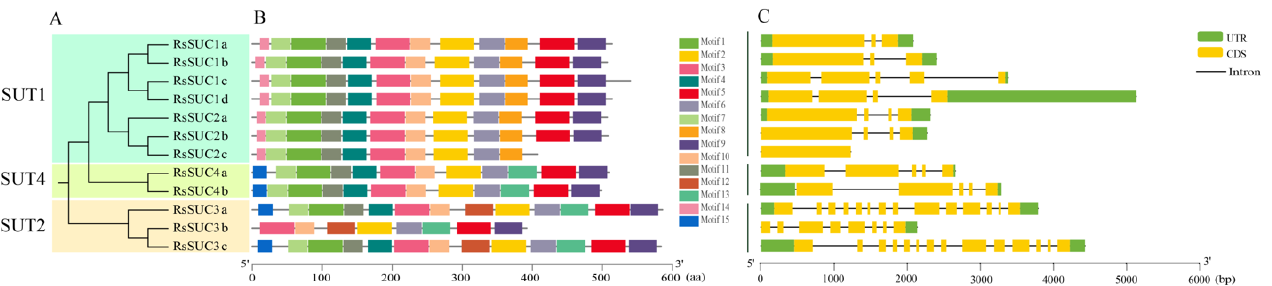
Figure 2. Conserved motifs and gene structure analysis of RsSUC genes. ( A ) Phylogenetic tree of RsSUC proteins. RsSUC proteins were divided into three subgroups (SUT1, SUT2 and SUT4), and each color group represented a subgroup. ( B ) Conserved motifs of RsSUC proteins. The 15 motifs were identified by using the MEME program, with each number of colored boxes representing a different motif; ( C ) Exon–intron structure of RsSUC genes. Boxes and lines represent exons and introns,